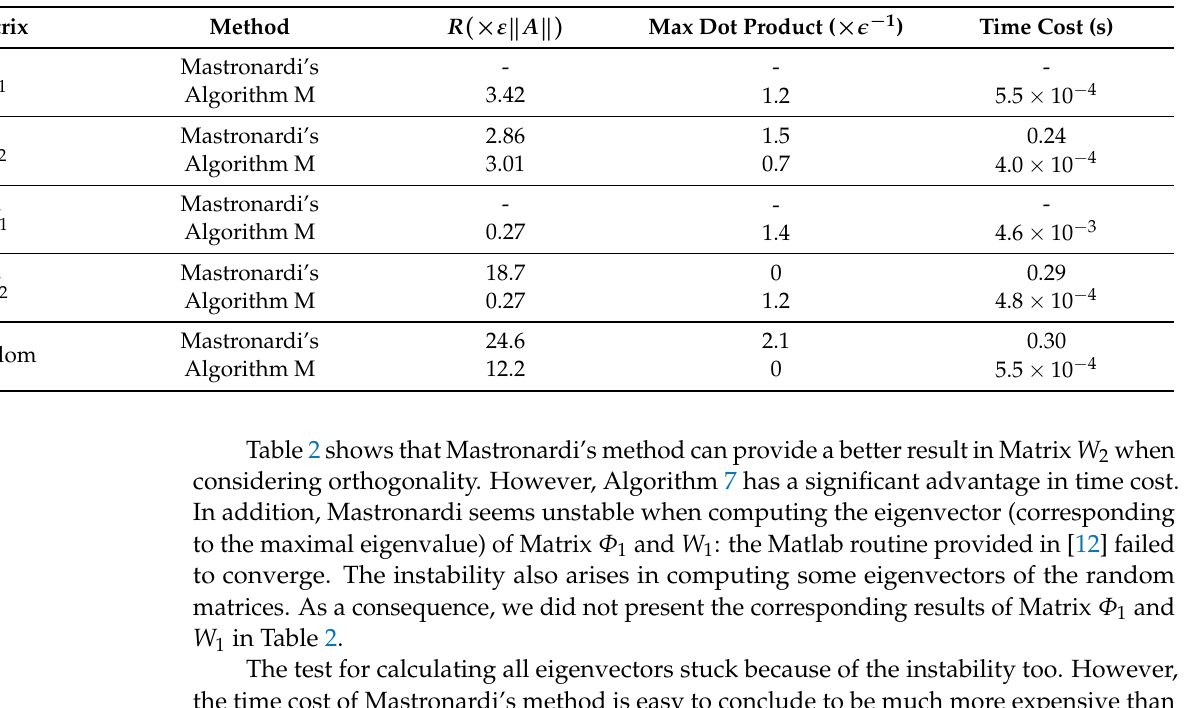
Table 2. Comparing with Mastronardi’s method when calculating one